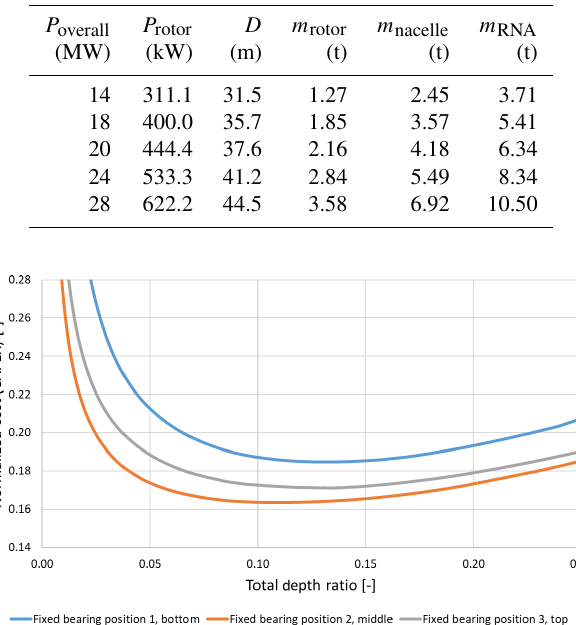
Table 3. Scaled rotor data for the 45-rotor MD-MRS.